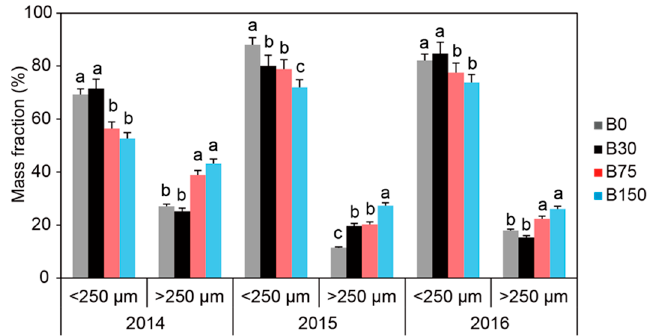
Figure 2. Changes of mass fractions of macro-aggregate (>250 μ m) and micro-aggregate (<250 μ m) from 2014 to 2016 in the soils amended with biochar at various rates. Different letters represent significant difference among the treatments at the same sampling day ( p < 0.05).